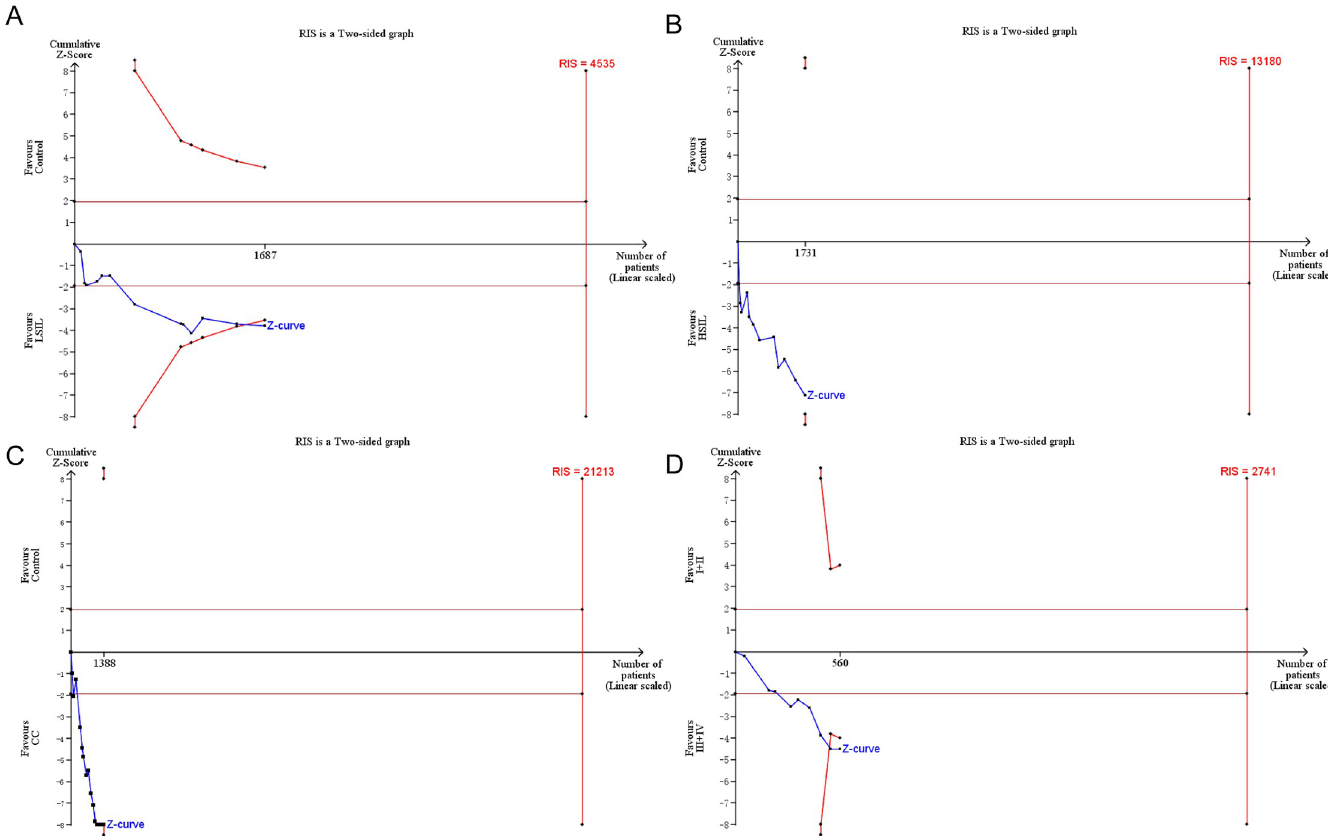
Fig 9. Trial sequential analysis estimating the required sample information in relation to LSIL (A), HSIL (B), CC (C) compared to controls and FIGO stage III or IV compared to FIGO stage I or II (D). Abbreviations: RIS, required information size.